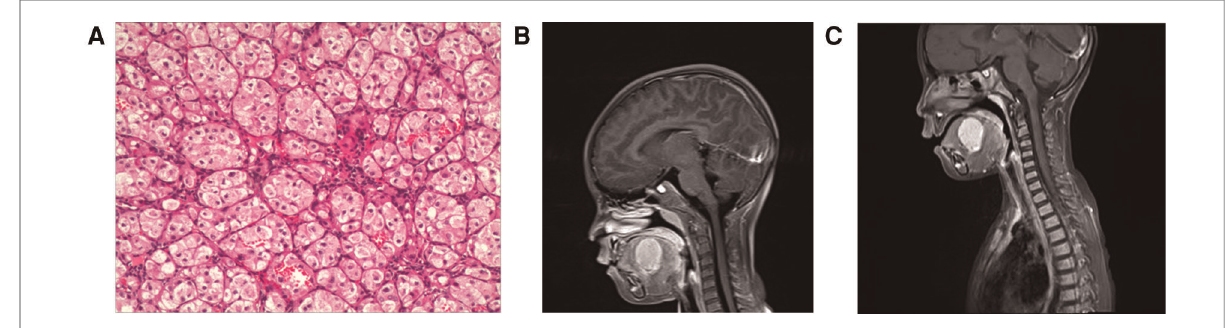
FIGURE 1 Pathological and radiological examination of case 1. ( A ) Microscopic examination shows that the tumor cells have abundant cytoplasm, eosinophilic, acinar, and nest-like growth. ( B ) MRI of the neck shows that the oval long T1 and long T2 signal masses could be seen on the left side of the mouth bottom, and the maximum cross-section was about 33 mm×24 mm×32 mm. ( C ) MRI of necks shows that mass did not shrink signi fi cantly after